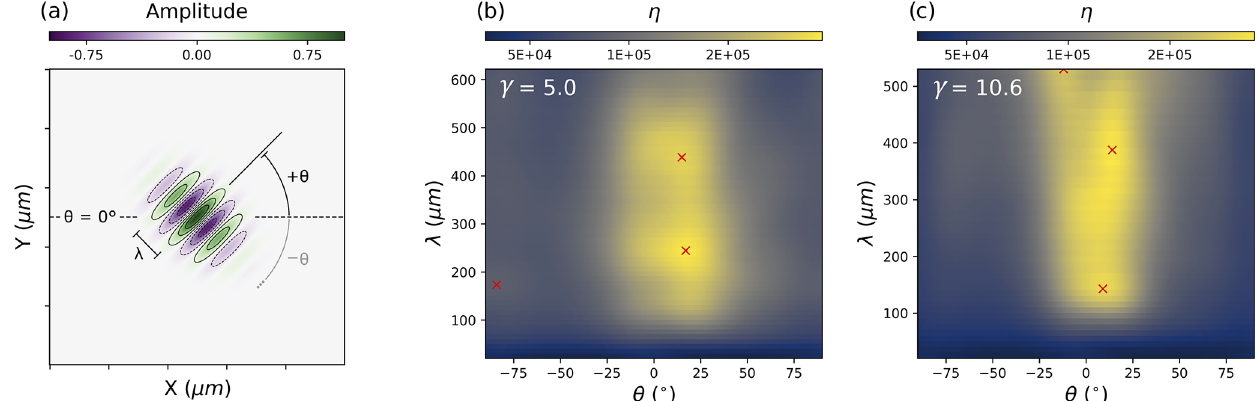
Figure 3. Wavelet analysis of partly ( γ = 5 . 0) and fully ( γ = 10 . 6) recrystallised samples. Panel (a) shows a generic 2D Morlet wavelet. The wavelet analysis is conducted by considering the wavelet’s interaction with the porosity density maps at each spatial position. This is repeated for different orientations ( θ ) and wavelengths ( λ ). Panels (b) and (c) visualise the wavelet analysis results for the two samples. Peaks in η represent the largest interaction with the wavelet (see Sect. A7 for details). Peaks are identified by local extremes in η and marked with red crosses. We note that two local extremes are not discussed in the text. This is because one was very close to the sensible limit of the analysis ( θ = − 12 ◦ , λ = 530µm) defined in Appendix A6 and the other did not correlate with any microstructural features ( θ = − 84 ◦ , λ = 173µm).